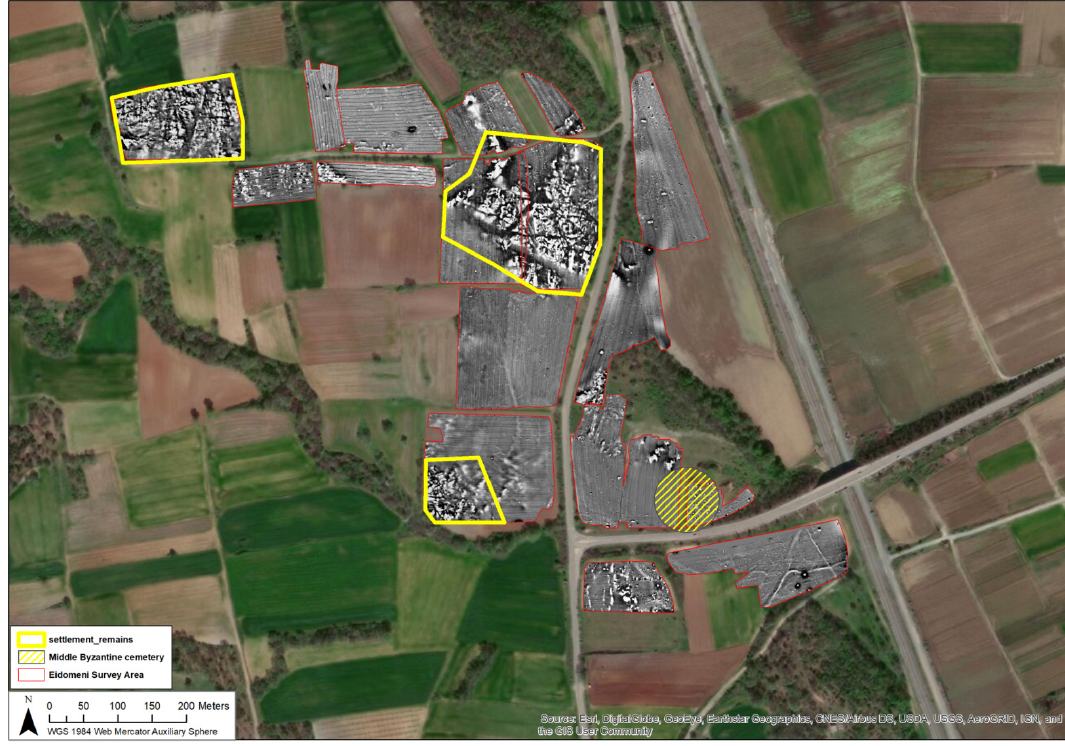
Figure 14. Structural features possibly of the Middle Byzantine settlement at Idomeni (WGS 1984, WebMercator Auxiliary